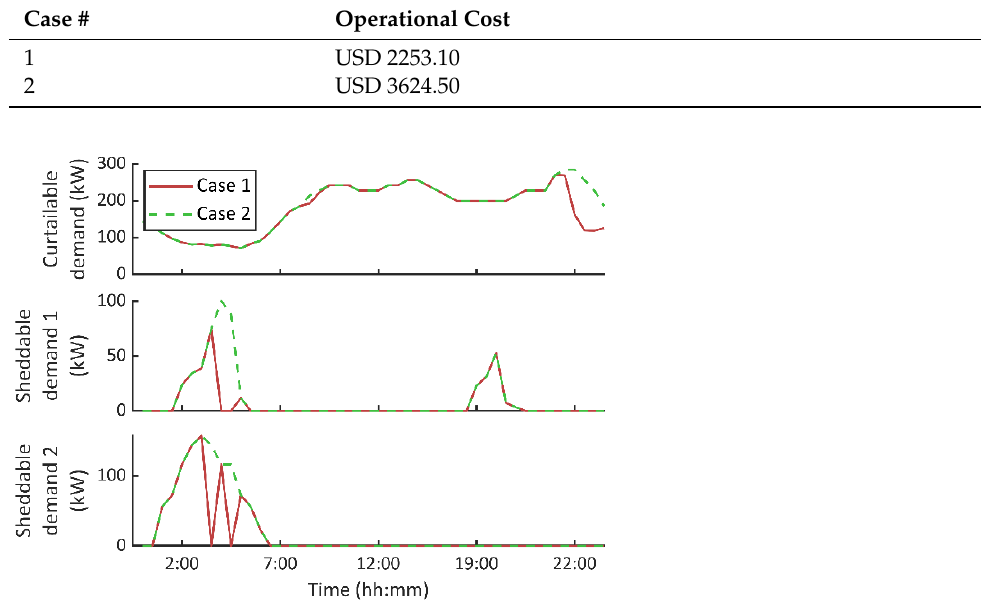
Table 8. Operational cost in the studied cases.